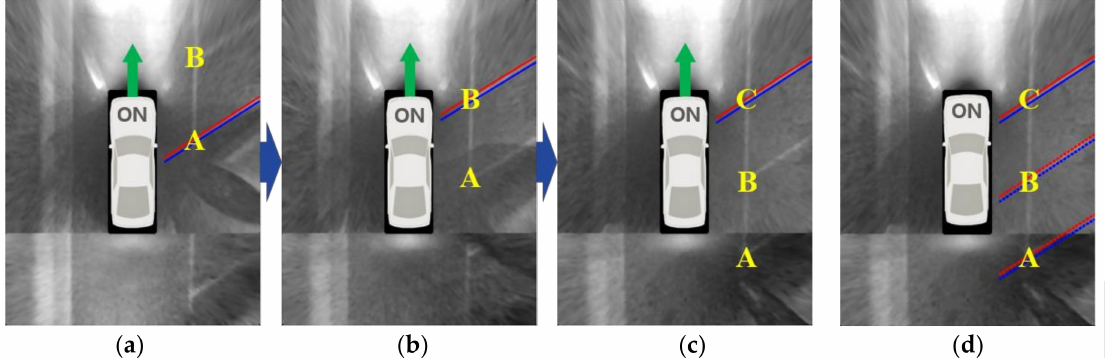
Figure 6. Separating line detection and tracking at night. ( a – c ) The consecutive detection results using only the current image; ( d ) The detection result obtained by combining the consecutive detection results via the vehicle-odometry-based tracking.